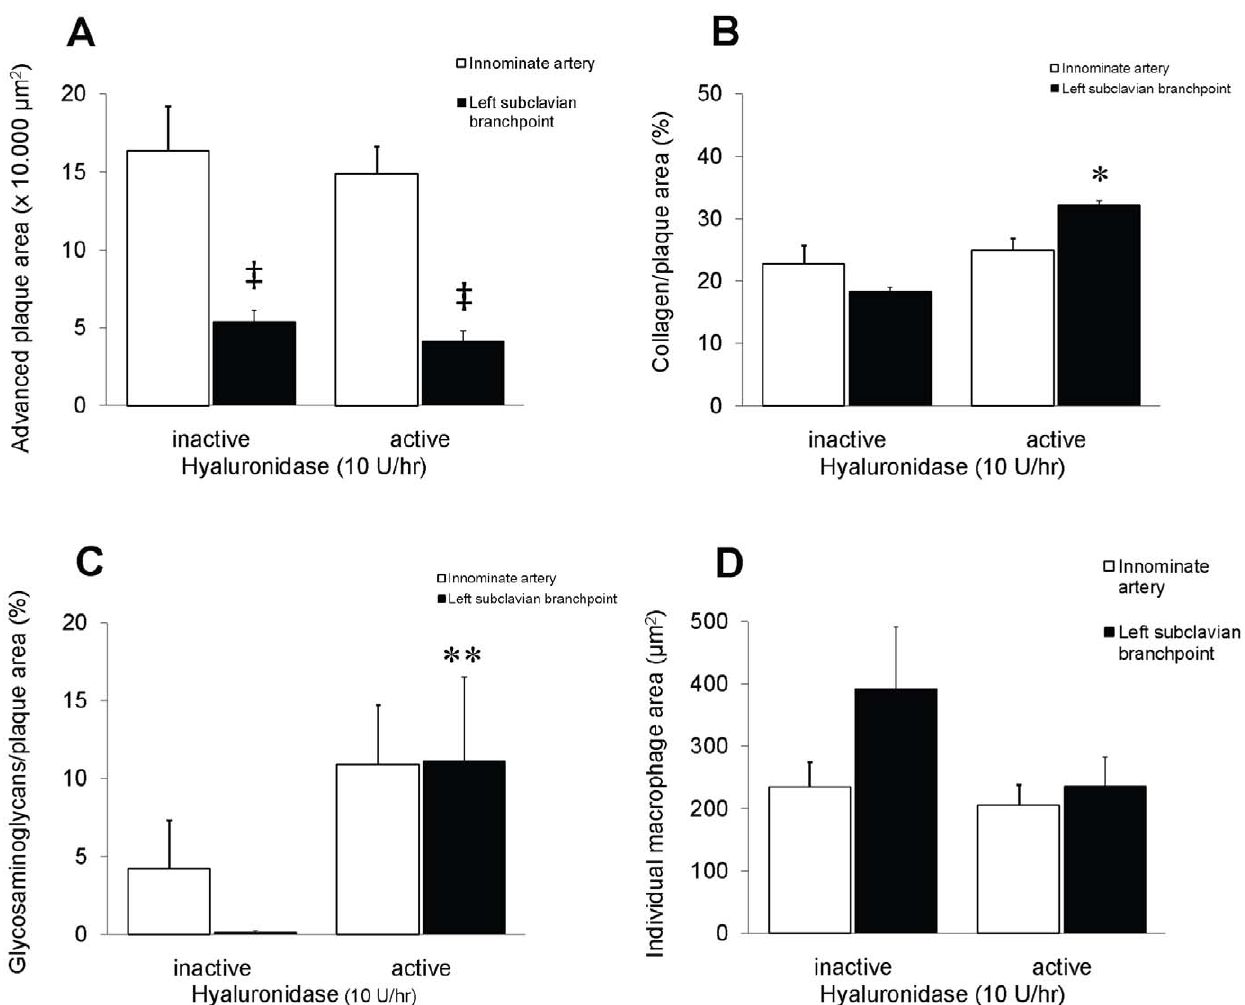
Figure 2. Atherogenic progression in the innominate- (white bars) and left subclavian (black bars) artery from apoE 2 / 2 mice on a combined Western-type atherogenic diet with inactive- or active hyaluronidase infusion. (A) Distribution and level of advanced plaque areas, given m m 2 6 10.000. Distribution and percentage of (B) collagen or (C) glycosaminoglycan within each plaque area. Distribution of individual macrophage areas within each plaque area (D), given in m m 2 .